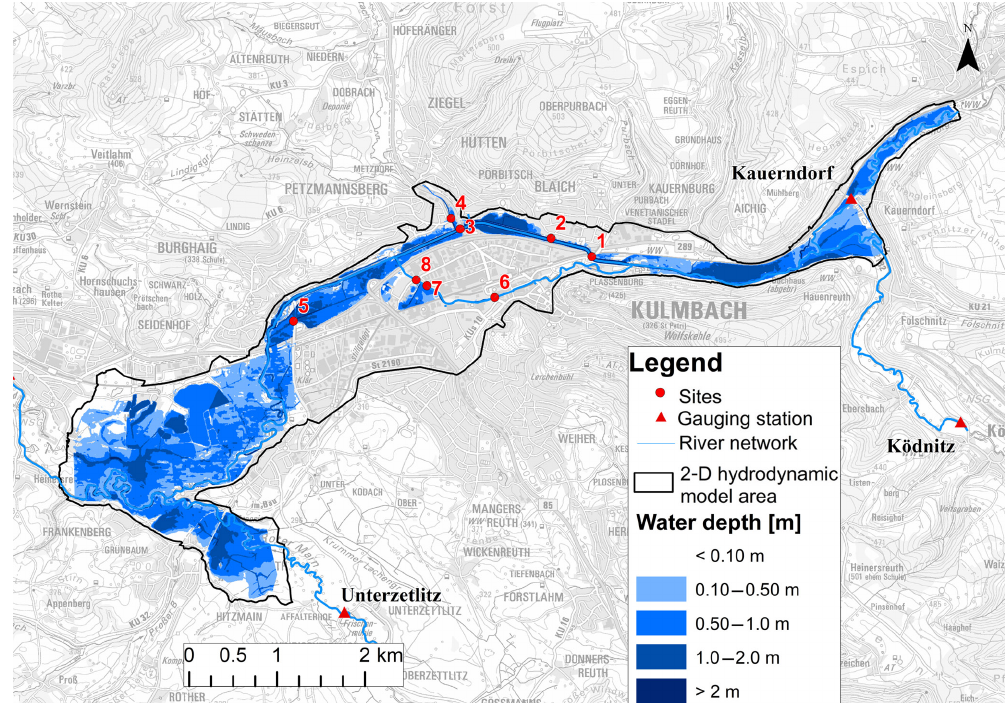
Figure 5. Inundation map for the flood event of January 2011 using the optimal model parameters, obtained using a least absolute error of 0.20m.